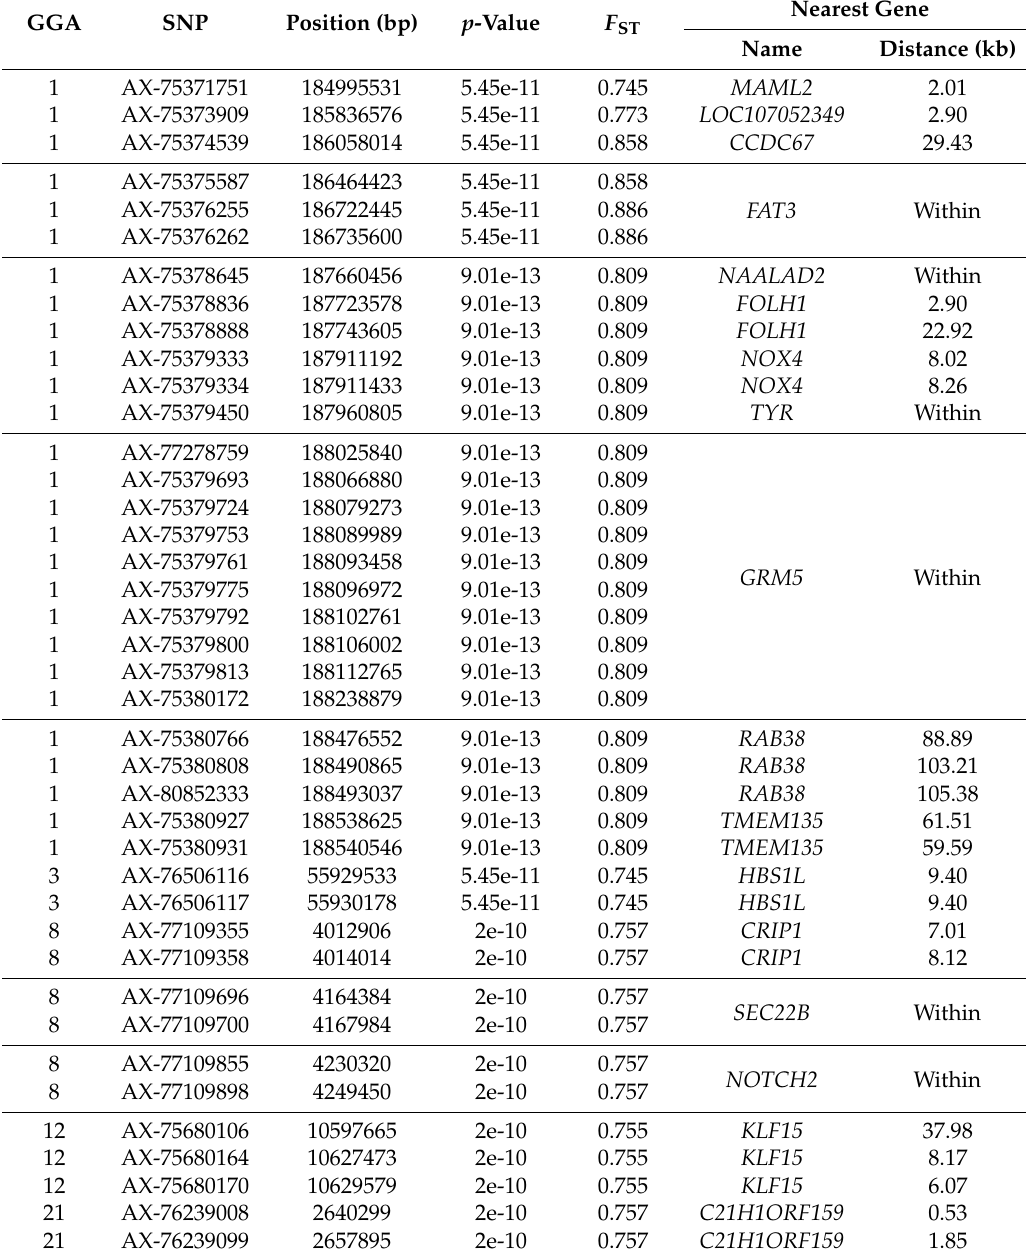
Table 1. Overlapping significant markers identified by GWAS and F ST and associated